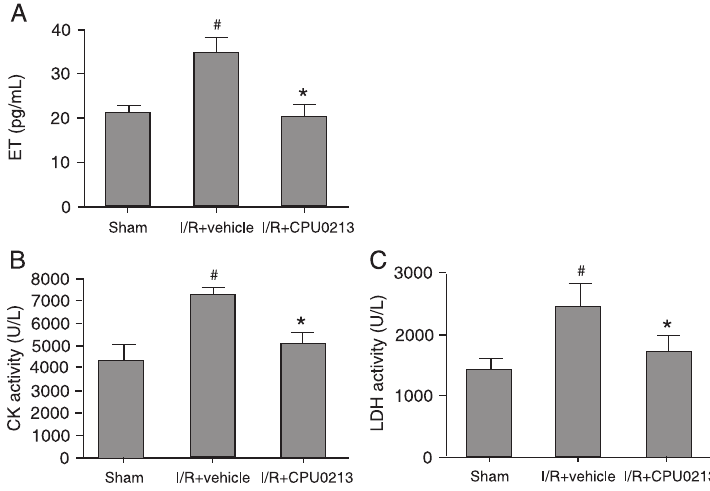
Figure 4. Endothelin-1 (ET-1) levels in plasma, and creatine kinase (CK) and lactate dehydrogenase (LDH) in serum after ischemia-reperfusion. A , ET-1 levels in plasma. B , Total CK activity in serum. C , Total LDH activity in serum. Data are reported as means ± SEM for 6 rats/group. # P < 0.05 vs Sham, *P < 0.05 vs I/R + vehicle (one-way ANOVA with the Bonferroni post hoc